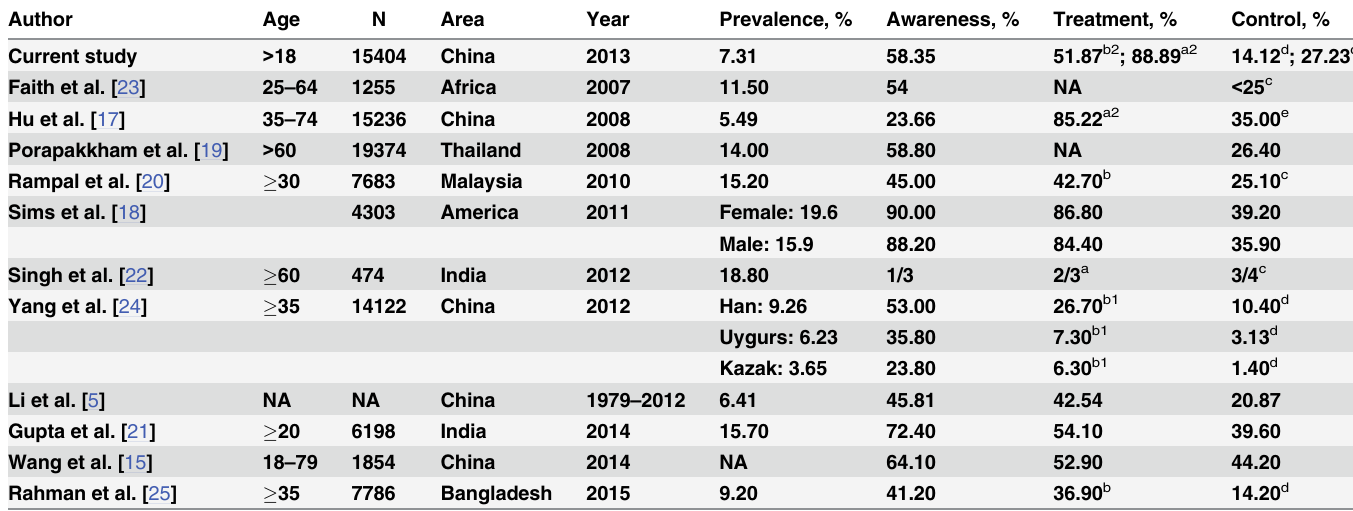
Table 7. Comparison of four DM-correlated rates in different areas.